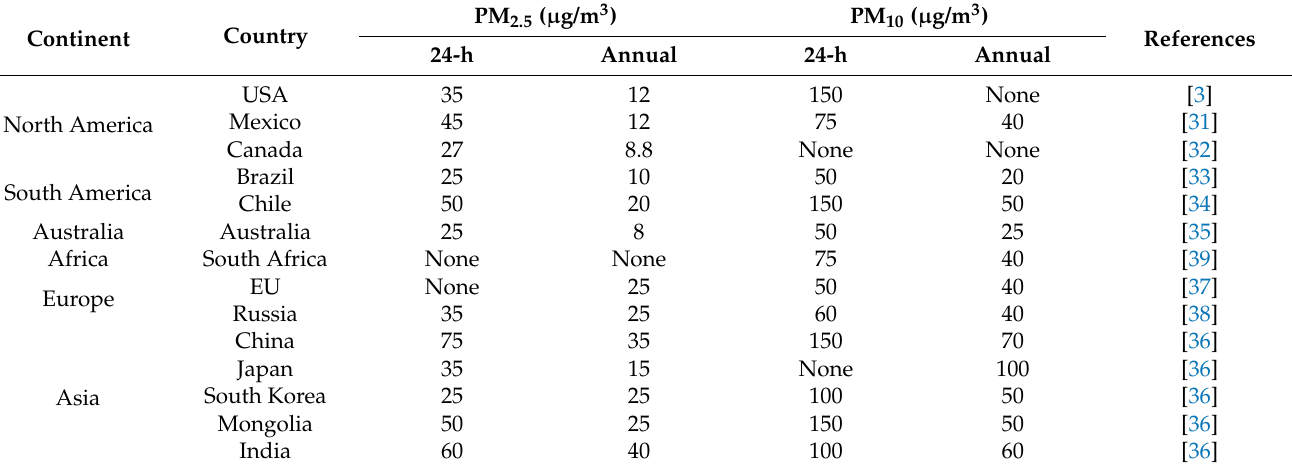
Table 1. Regulation standards of PM 2.5 and PM 10 set by several